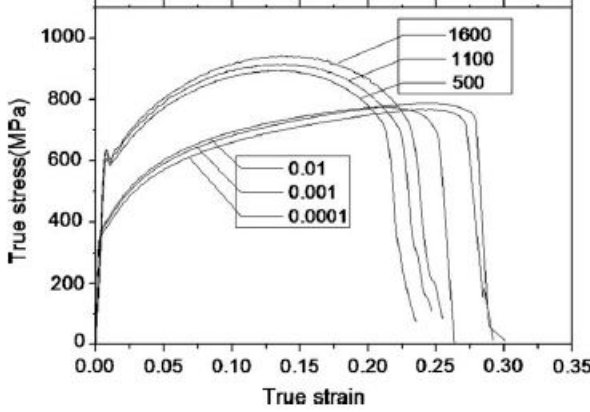
Figure 27. True stress–strain curve at different strain rates [159] .